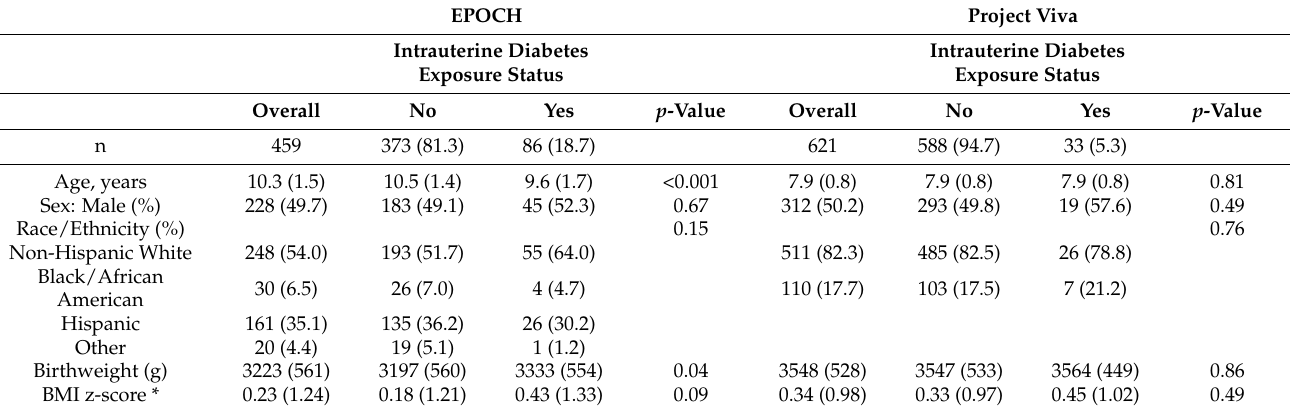
Figure 1. Flow chart for inclusion in this study. Table 1. EPOCH and Project Viva participants’ characteristics by intrauterine diabetes exposure status.